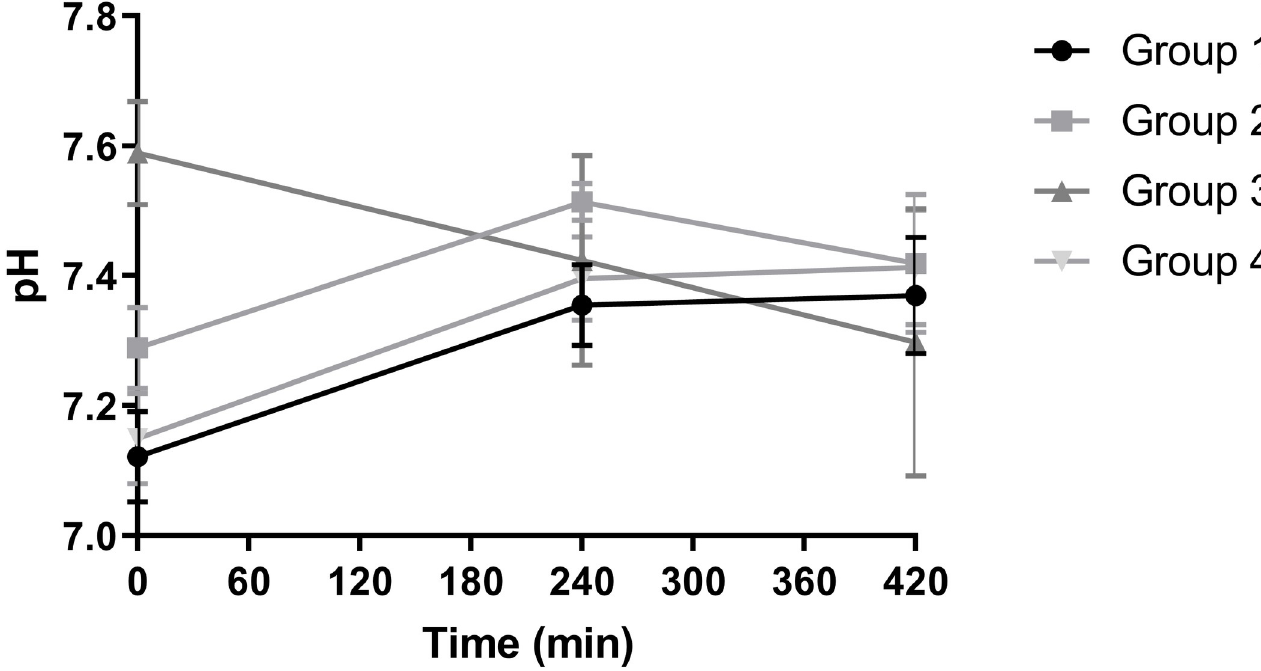
Fig 5. pH of the four experimental groups during NMP (mean +